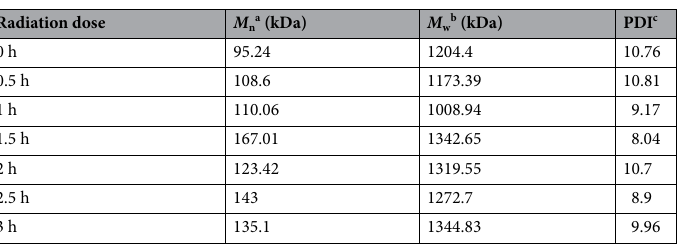
Table 2. Molecular weights (GPC) of PAAm with different radiation exposures. a Number-average molecular weight ( M n ). b Weight-average molecular weight ( M w ). c Polydispersity index ( M w / M n ) determined by GPC with